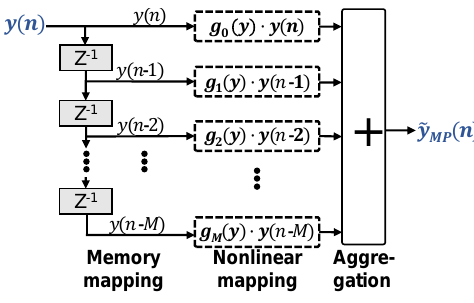
Figure 2. Memory polynomial nonlinear